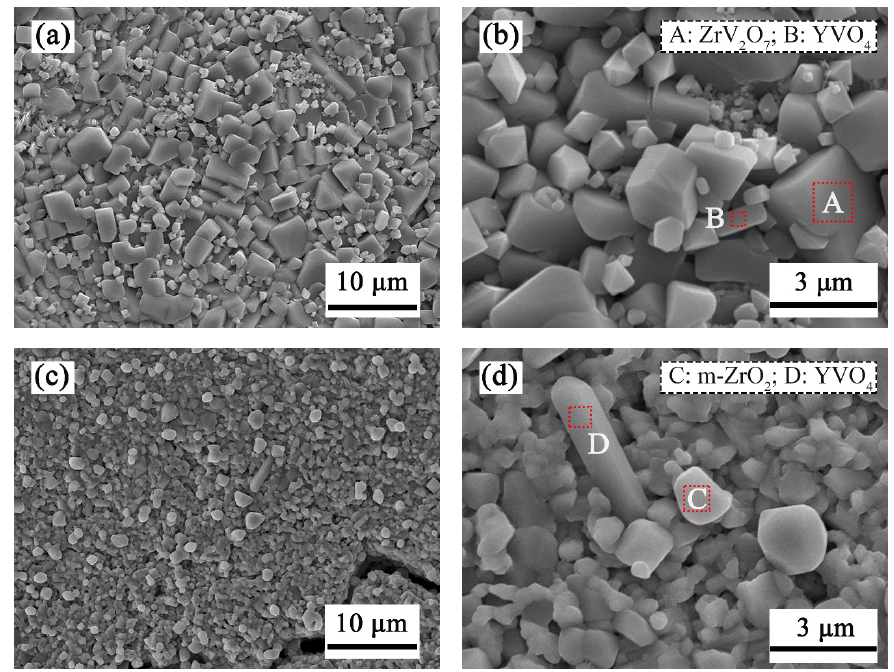
Fig. 8 Surface morphologies of the laser glazed YSZ coatings after hot corrosion tests at (a, b) 700 ℃ and (c, d) 1000 ℃ . D. The chemical compositions of these crystals